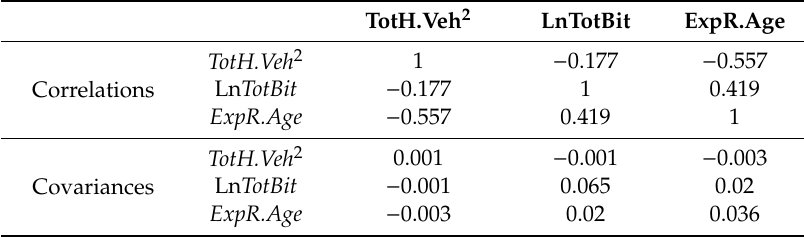
Table 8. Coe ffi cient of correlation, R , between the independent variables of the model of Equation